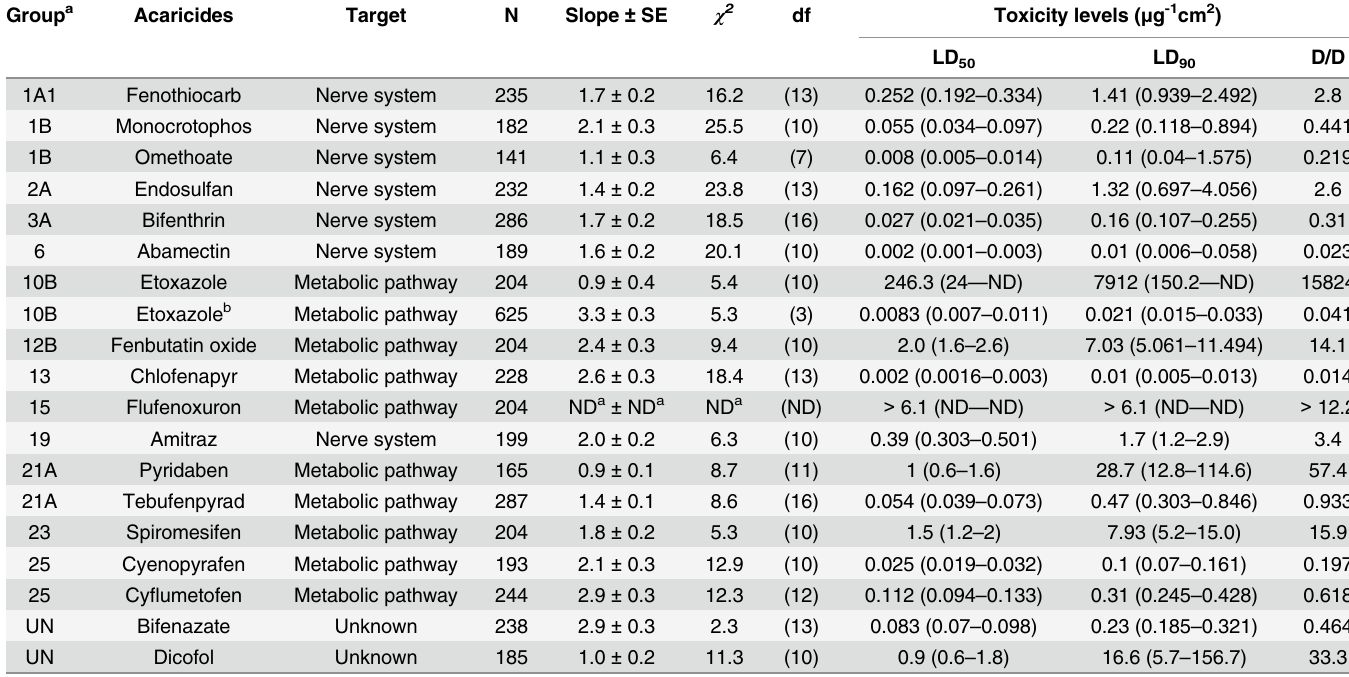
Table 3. Toxicity parameter by residual contact vial bioassay to PyriF strains in Tetranychus urticae . Group